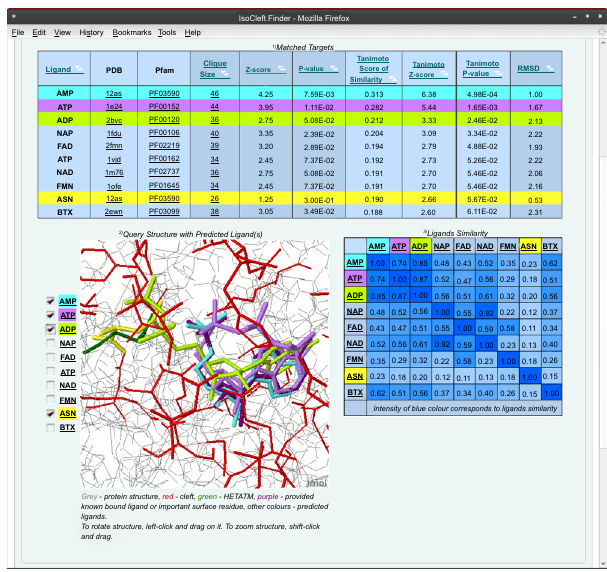
Figure 5. Example of the IsoCleft Finder output containing the list of hits (top) superimposed on the query binding-site of 12as (bottom left) and the target ligand similarities (bottom right). See